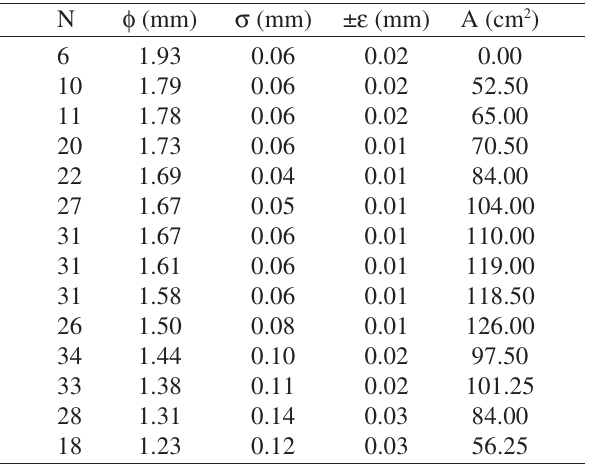
Table 3. Marble cutting data with the in situ diamond